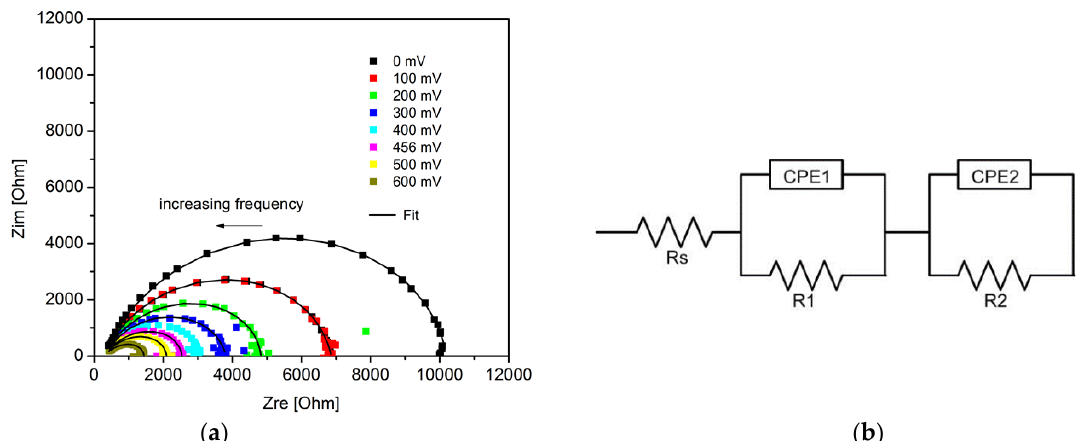
Figure 5. Impedance spectra in dependence of applied forward voltage ( a ) and equivalent circuit used for modeling ( b ) of flexible P3HT:PCBM-based solar cells constructed on PET substrates.